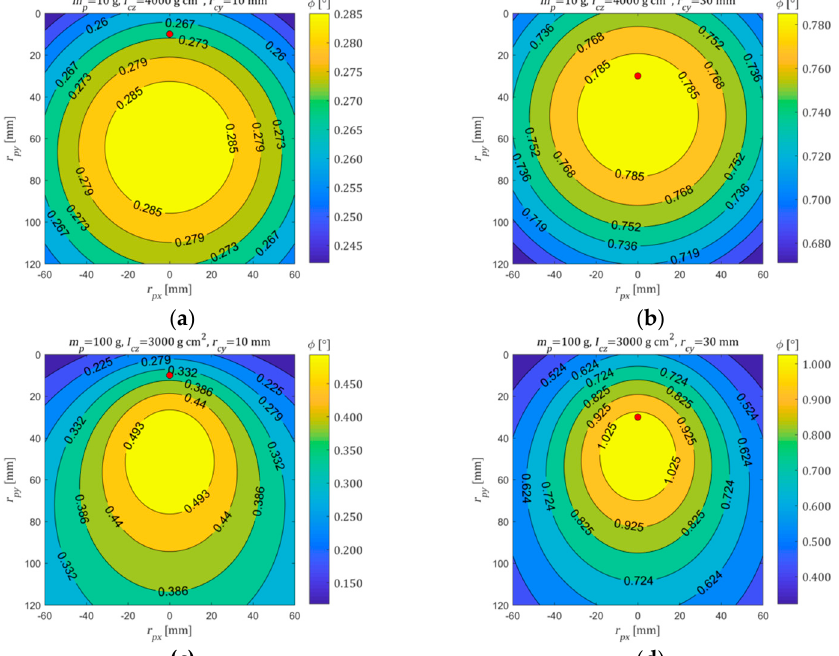
Figure 3. Launch direction ( (cid:2038) ) for 15 mm toe impact based on discretionary mass placement. Final clubhead mass is 360 g. ( a ) Scenario 1; ( b ) Scenario 2; ( c ) Scenario 3; ( d ) Scenario 4.